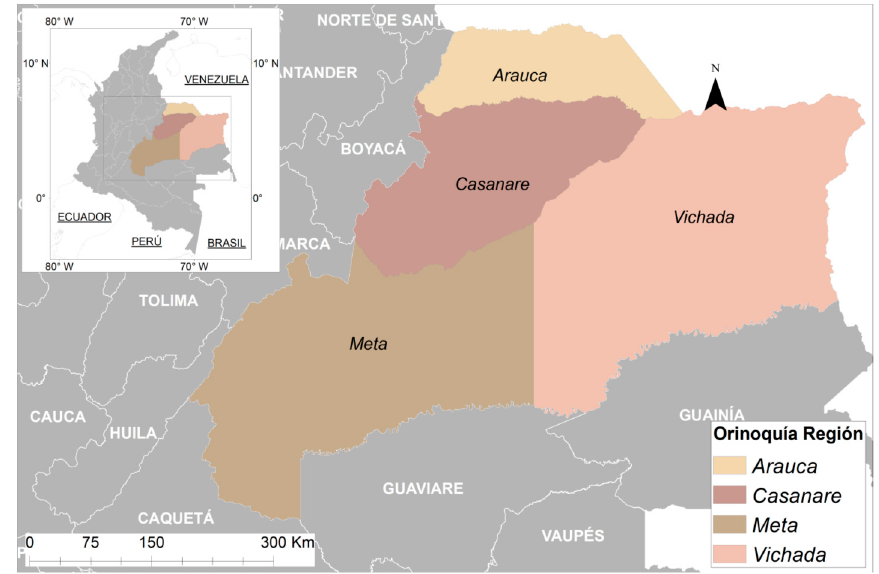
Figure 1. The Orinoquia region, as prioritized by the Colombian government in its efforts to reduce forest-based emissions, addresses the causes of armed conflict, and achieves sustainable food production.